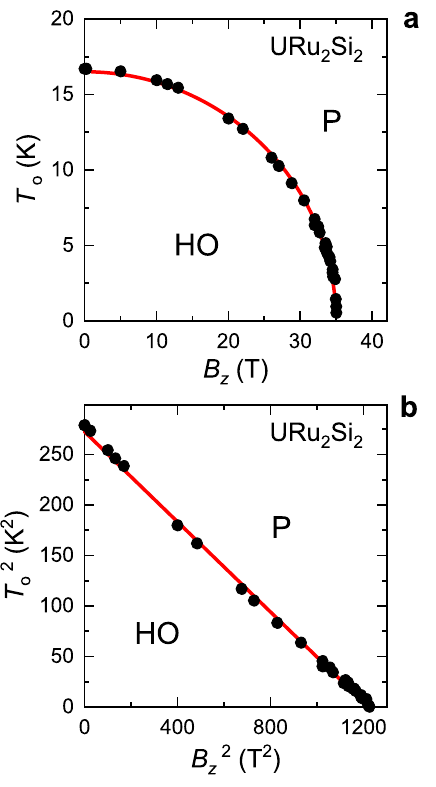
Fig. 5 Elliptical phase diagram. a T o ( B z ) phase boundary of URu 2 Si 2 , taken from the peak in the speci fi c heat capacity at the transition 49,50 and the step in the resistivity at high fi elds 74 , where B z refers to the magnetic fi eld applied along the crystalline c -axis. The solid line represents a fi t to Eq. (7). We neglect the additional phase transitions at B ≳ 36 T 74 . b Same data plotted in T 2